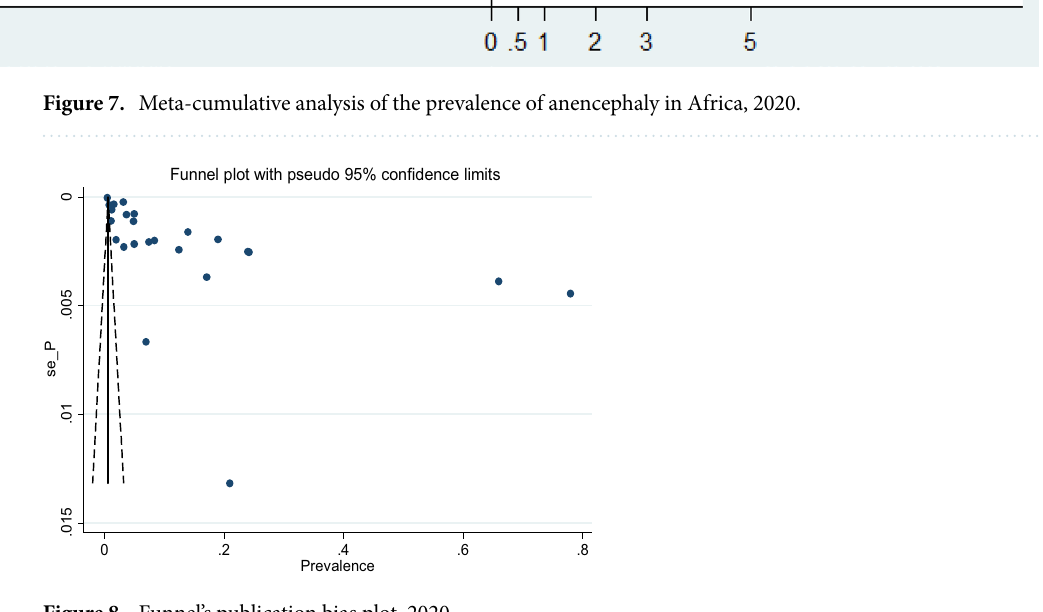
Figure 8. Funnel’s publication bias plot,